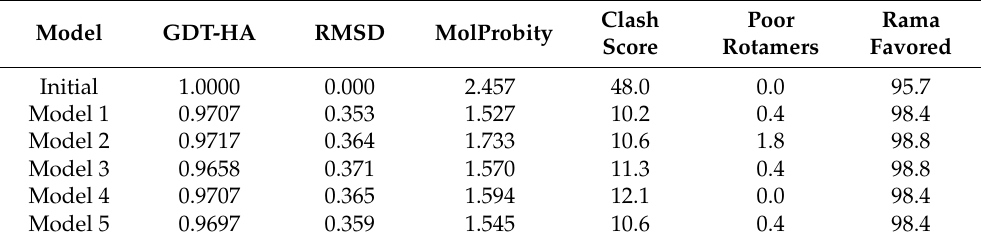
Figure 6. ( A )Vaccine construct’s 3D crystal structure, ( B ) refined vaccine 3D structure model, ( C ) assessment of the Ramachandran plot for the multi-epitope vaccine construct, and ( D ) a ProSA-web validation of the vaccine 3D structure. The Z-score of the refined model is − 7.5, which lies inside the score range ( E ) residue’s score plot by ProSA-web to verify the local model quality. There was an improvement in the Ramachandran plot score from 95.7% to 98.8% af- Table 5. Predictions of the models’ quality scores by